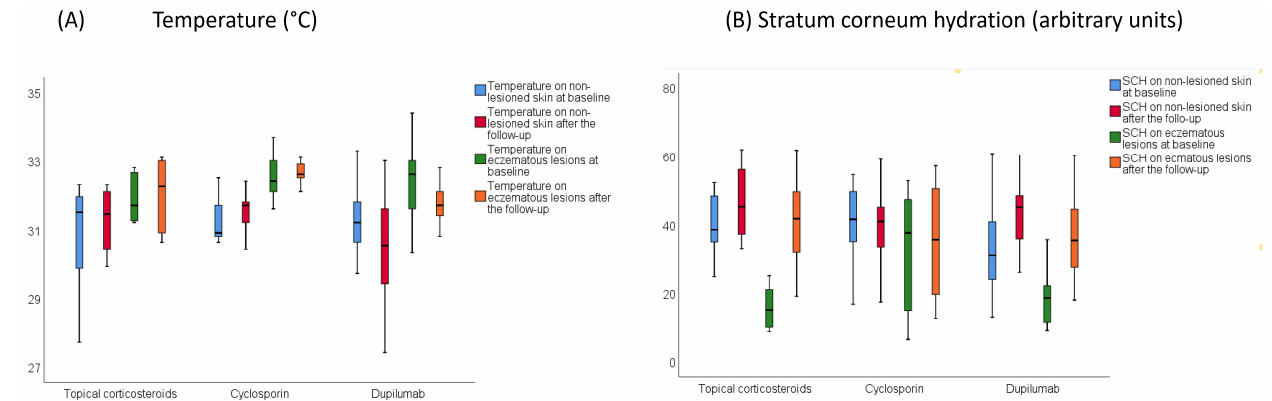
Figure 4. Changes in skin barrier function parameters after receiving each treatment. A ) Tempera- ture ( B ) Stratum corneum hydration. ( B ) Stratum corneum